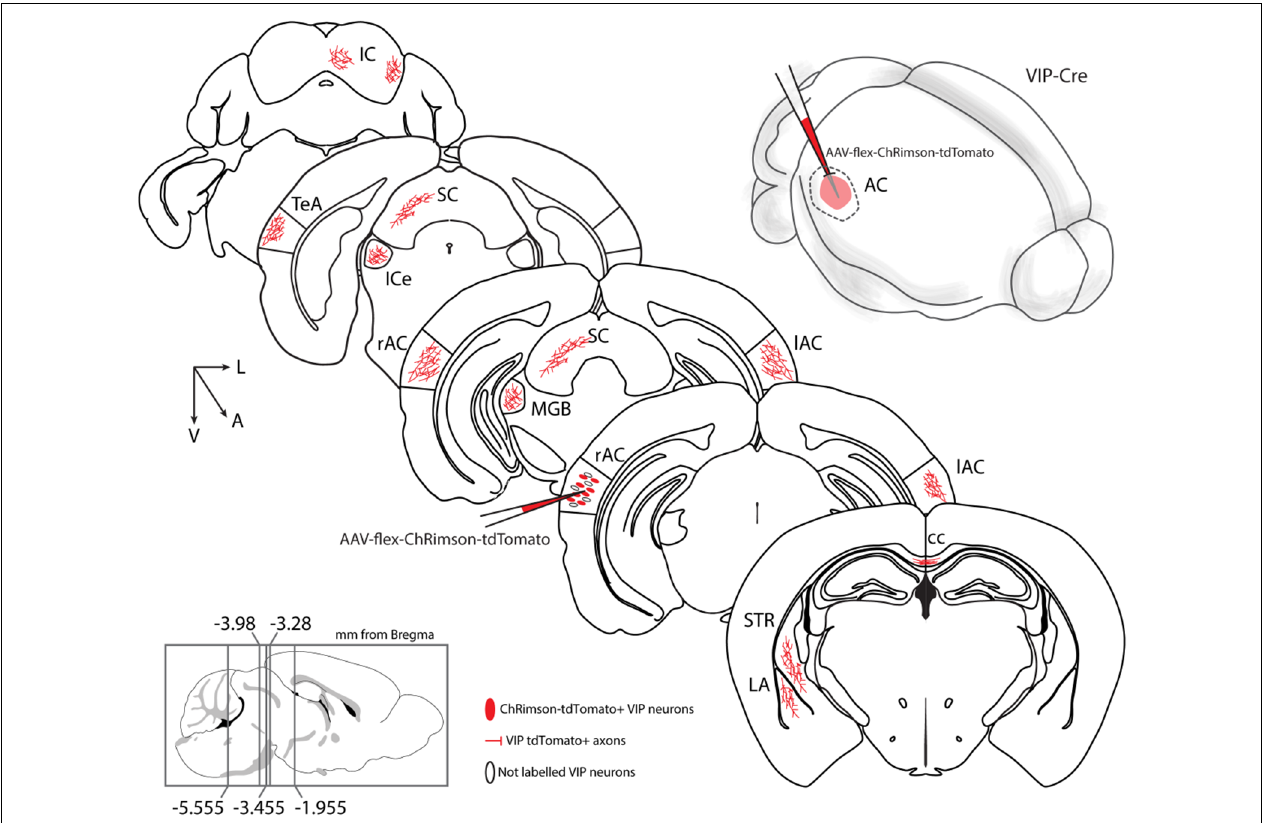
FIGURE 9 | Summary diagram: long-range VIP-expressing neuron projections. Top right: schematic representation of auditory cortex injection with AAV-flex-ChRimson-tdTomato. VIP long-range axons were found in several areas: AC, auditory cortex, right, and left; cc, corpus callosum; ipsilateral ICe, inferior colliculus, external; ipsilateral IC, inferior colliculus; ipsilateral LA, lateral amygdala; ipsilateral MGB, medial geniculate body, ipsilateral SC, superior colliculus; ipsilateral STR, striatum; ipsilateral TeA, temporal association